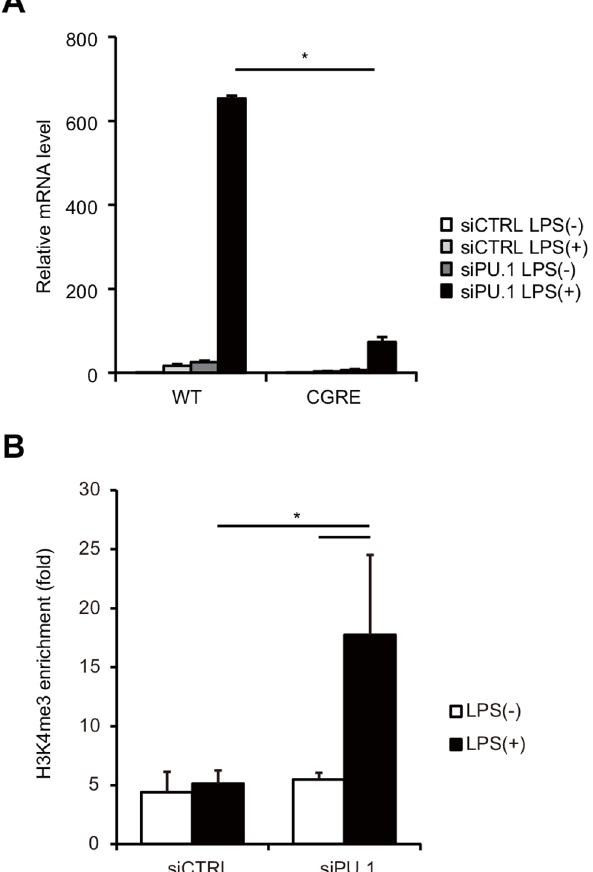
Fig 6. PU.1 knockdown enables GATA3 to transactivate the Il13 promoter via affecting histone H3 modification of CGRE. (A) BMDCs from wild type (WT) or CGRE deletion ( Δ CGRE) mice were transfected with either control siRNA (siCTRL) or PU.1 siRNA (siPU.1). After 48 h incubation, the cells were stimulated or not with 1 μ g/ml LPS for 6 h. Relative mRNA levels (IL-13/GAPDH) were determined by quantitative RT-PCR after normalizing to GAPDH mRNA. * , p < 0.05 in a two-tailed paired Student ’ s t test. (B) Quantification of the H3K4me3 degree around CGRE on the Il13 promoter was performed by a ChIP assay with anti-H3K4me3 antibody or its control antibody, and a primer set described in S1 Table. All results are means ± S.E.s ( n = 3). Similar results were obtained in another experiment. * , p < 0.05 in a two-tailed paired Student ’ s t